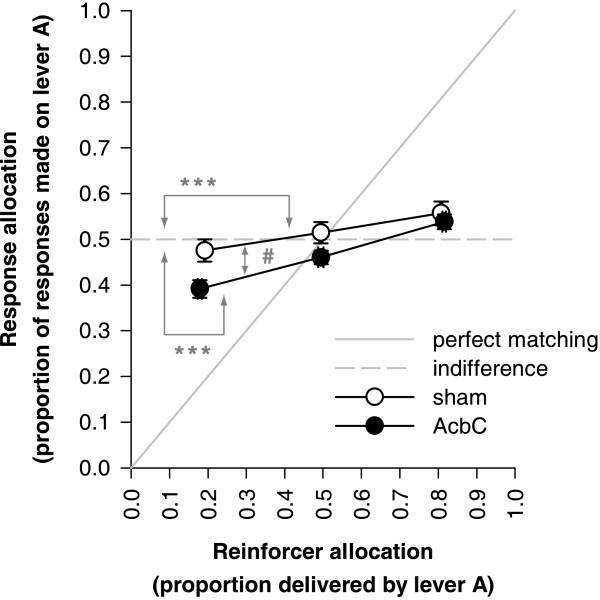
Discrimination of reinforcer magnitude: matching of relative response rate to relative reinforcement rate AcbC-lesioned rats exhibited better sensitivity to the difference between 1 and 4 food pellets than shams did. Subjects responded on two concurrent RI-60-s schedules, designated A and B, and the reinforcer magnitude for each schedule was varied. Data from the last session of each condition are plotted (sessions 11, 19, and 27; see Table 1); programmed reinforcement ratios were 0.2 (1 food pellet on schedule A and 4 pellets on schedule B), 0.5 (1:1 pellets), and 0.8 (4:1 pellets). The abscissa (horizontal axis) shows experienced reinforcement ratios (mean ± SEM); the ordinate (vertical axis) shows response allocation (mean ± SEM). Both groups exhibited substantial undermatching (deviation away from the predictions of the matching law and towards indifference). However, neither group was indifferent to the reinforcement ratio: the sham and AcbC groups both adjusted their response allocation towards the lever delivering the reinforcer with the greater magnitude (*** p < .001). Matching was better in AcbC-lesioned rats than in shams (lines of different gradient, # p = .021), suggesting that they were more sensitive to the difference between 1 and 4 food pellets.